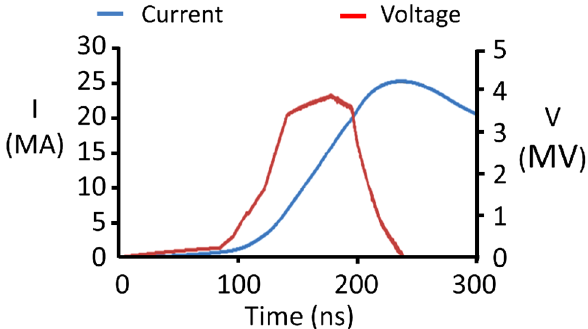
FIG. 10. The voltage and current at the MITL input versus time are shown as computed with Screamer for the surrogate load on the Z Machine with the standard four-level MITL and PHC. The voltage source was inferred from shot